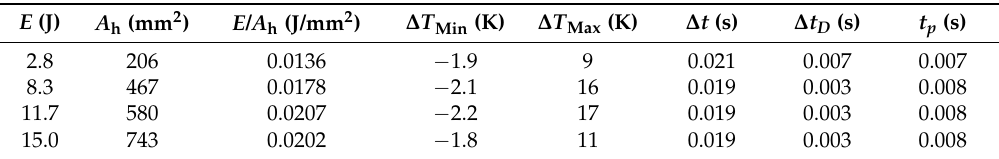
Table 1. Some data for varying impact energy.